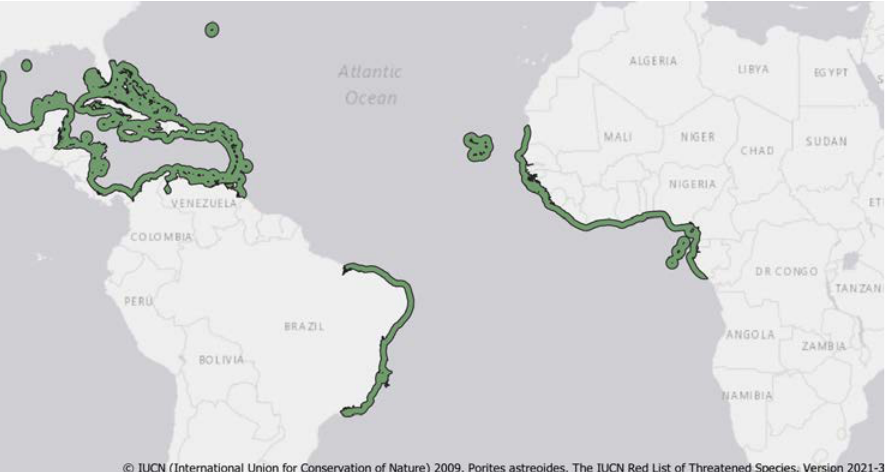
Figure 2. Geographic distribution of the mustard hill coral ( Porites astreoides ) in the Atlantic Ocean, indicated in green [20].